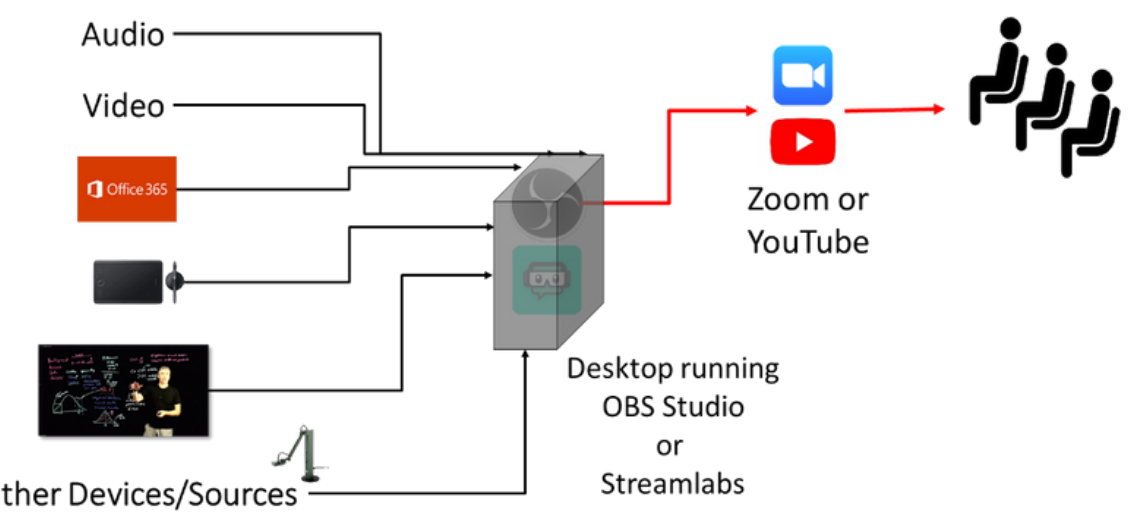
Figure 7. Basic input/output schematic of our online teaching platforms. Various input devices such as audio, video, slides, writing tablet, document camera, and lightboard are incorporated into a software platform such as OBS Studio or Streamlabs, arranged in various ‘scenes,’ and then streamed to students via Zoom, YouTube Live, or some other videoconference